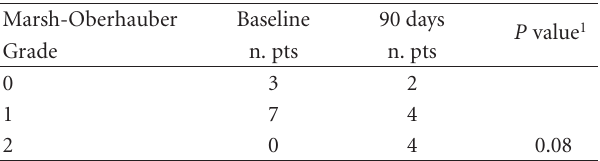
Figure 2: Activity of mTG in wheat flour. (a) SDS-PAGE of protein fractions following mTG-mediated transamidation of flour in the presence of MDC; the bands were visualized by UV (left) or Coomassie blue staining (right). (b) Quantification of lysine cross-linked to gliadins and glutenins following wheat flour transamidation with K-CH 3 ; results are expressed as nmoles α -amino N/mg protein, and the statistical assessment was performed using the Student’s t test; ∗ : P < 0 . 05. (c) Baking features of dough following transamidation. Inset, gluten content in the sample breads as determined by R5-ELISA (Imbiosis, Madrid, Spain). These results are representative of five di ff erent experiments. Table 3: Biopsy analyses following a 90-day K-CH 3 -gluten chal-